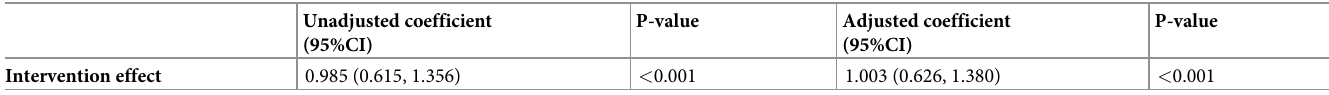
Table 3. Changes in dietary diversity score due to nutrition